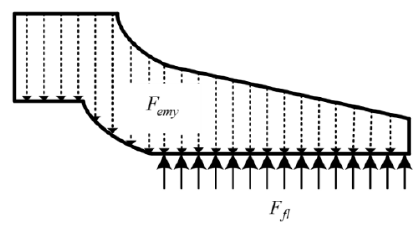
Figure 3. Force analysis of armature.